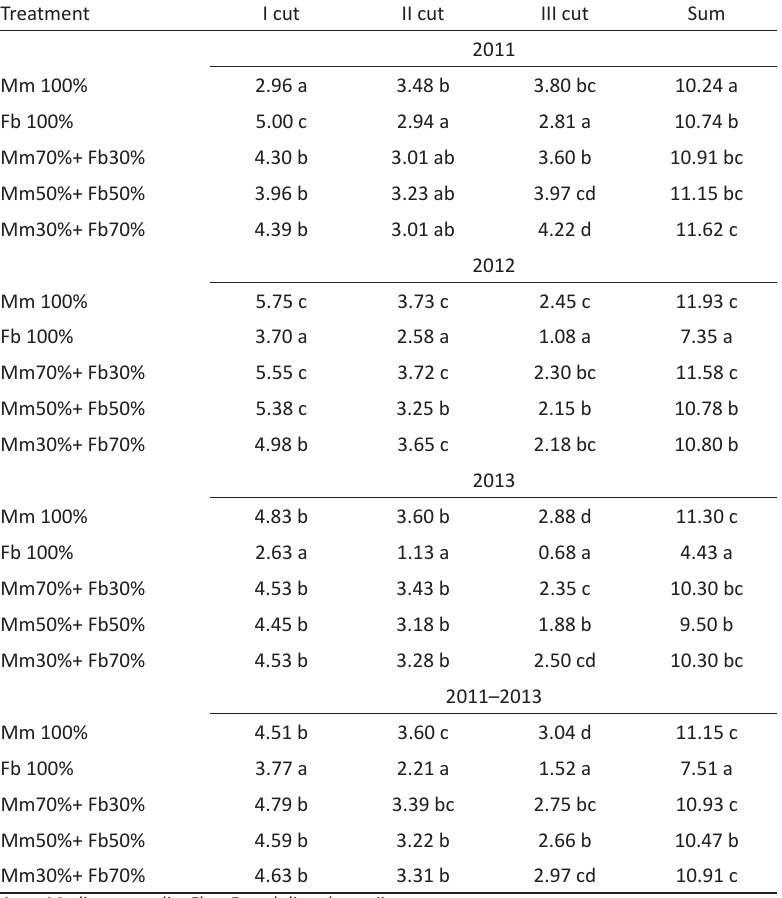
Table 2. Dry matter yield (Mg ha -1 )